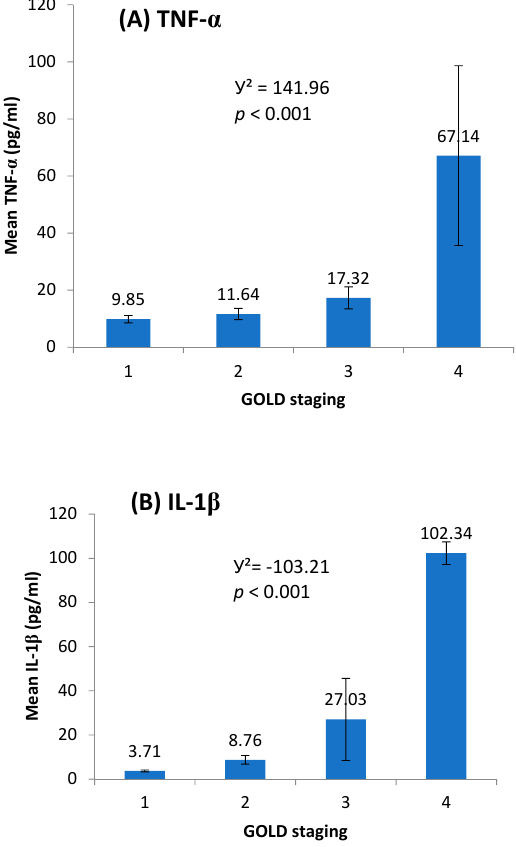
Figure 3. Dose response relationship between ( A ) tumour necrosis factor alpha (TNF- α ) (pg/mL), ( B ) interleukin 1 beta (IL-1 β ) (pg/mL), and global initiative for Chronic Obstructive Lung Disease GOLD staging among COPD cases. The p values for the difference in mean levels of TNF- α and IL-1 β between GOLD staging are: Stage 1 vs. Stage 2: TNF- α 0.81, IL-1 β 0.67; Stage 1 vs. Stage 3: TNF- α 0.31, IL-1 β 0.032; Stage 1 vs. Stage 4: TNF- α 0.000, IL-1 β 0.000; Stage 2 vs. Stage 3: TNF- α 0.20, IL-1 β 0.000; Stage 2 vs. Stage 4: TNF- α 0.000, IL-1 β 0.000; Stage 3 vs. Stage 4: TNF- α 0.000, IL-1 β 0.000.